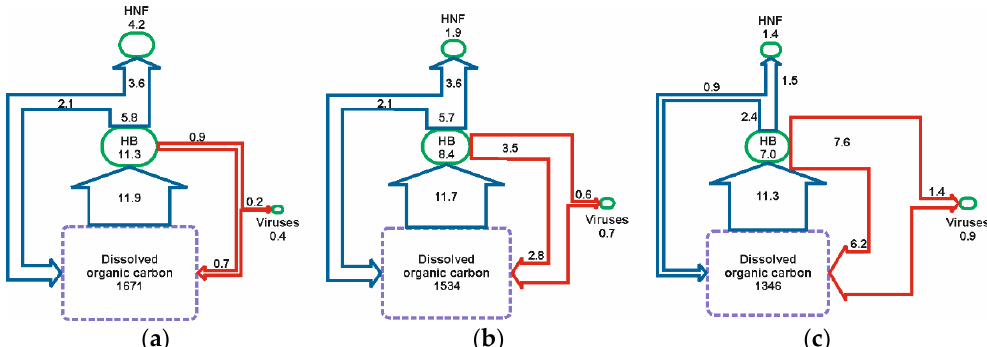
Figure 4. Diagrammatic representation of shifting carbon flow through the microbial loop (blue lines) and viral shunt (red lines) from: ( a ) December 2010, ( b ) to January 2011, and ( c ) to February 2011. Green boxes represent the carbon contained within the biogenic pools of heterotrophic bacterioplankton (HB), virioplankton, and heterotrophic nanoflagellates (HNFs) and values given have the units µ g C L − 1 . Arrows represent the flux of carbon from one pool to another and values given have the units µ g C L − 1 day − 1 . Size of the boxes and thickness of the arrows is indicative of the magnitude of the carbon they represent with the exception of dissolved organic carbon (purple box), which, given its much greater magnitude, is not drawn to scale with the other budget com- ponents.